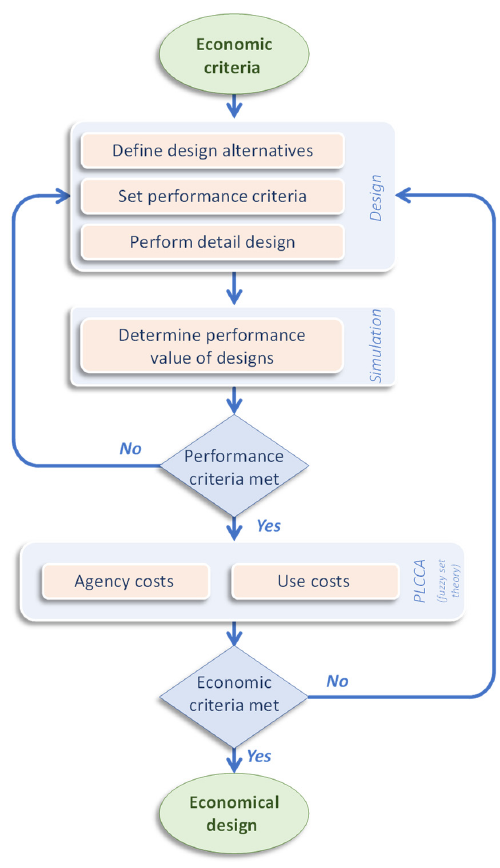
Figure 4. Probabilistic life cycle cost analysis framework.